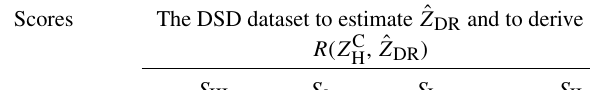
, ˆ Z DR ) calculated by different H